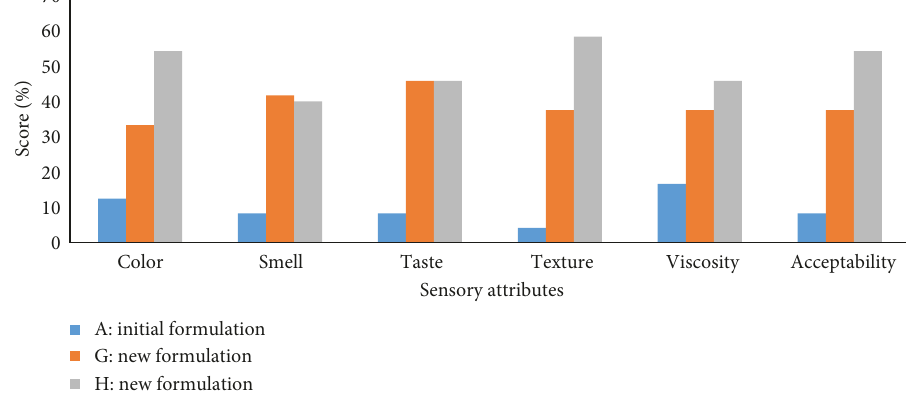
Figure 3: Preference (%) ranking of different Kiptaruswo’s family porridge against different sensory